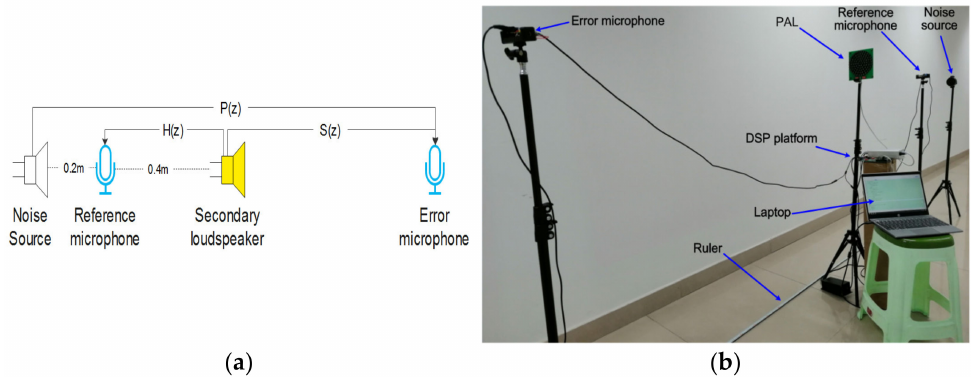
Figure 7. Experiment with laying scenes: ( a ) schematic diagram; ( b ) specific experimental scenarios.